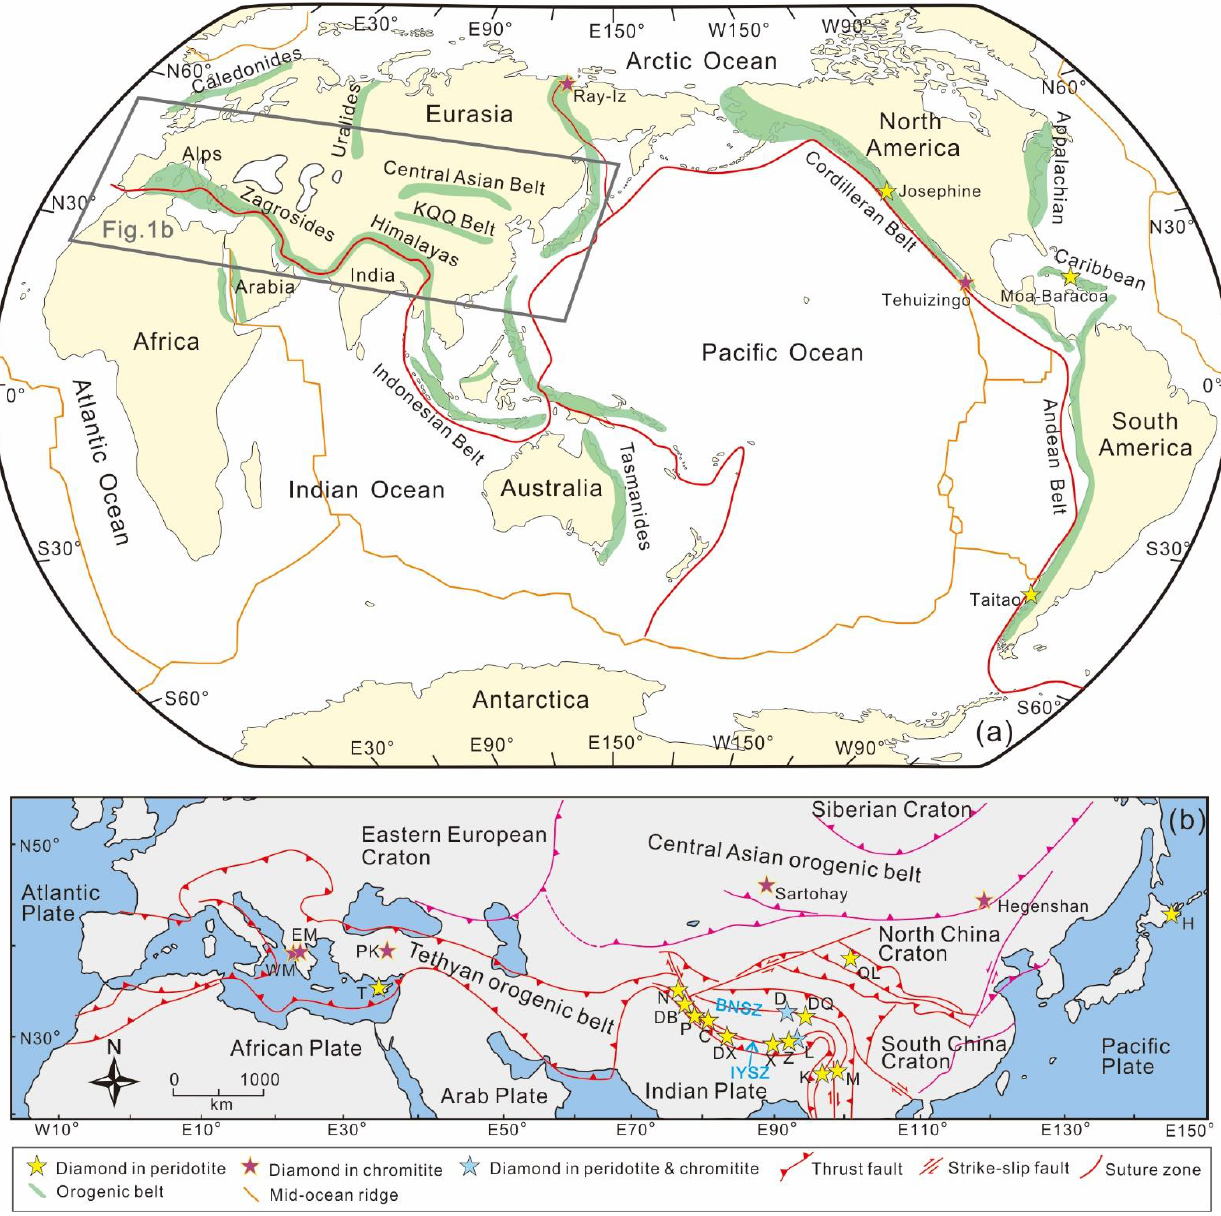
Figure 1. Distribution of twenty-five diamond-bearing ophiolites reported on the globe ( a ). Nineteen diamond-bearing ophiolites are distributed along the Neotethyan Orogenic Belt, Kunlun – Qilian – Qinling Paleotethyan Orogenic Belt (KQQ), Central Asian Orogenic Belt and Hidaka metamorphic belt ( b ). Ophiolites: C — Cuobuzha, D — Dongqiao,